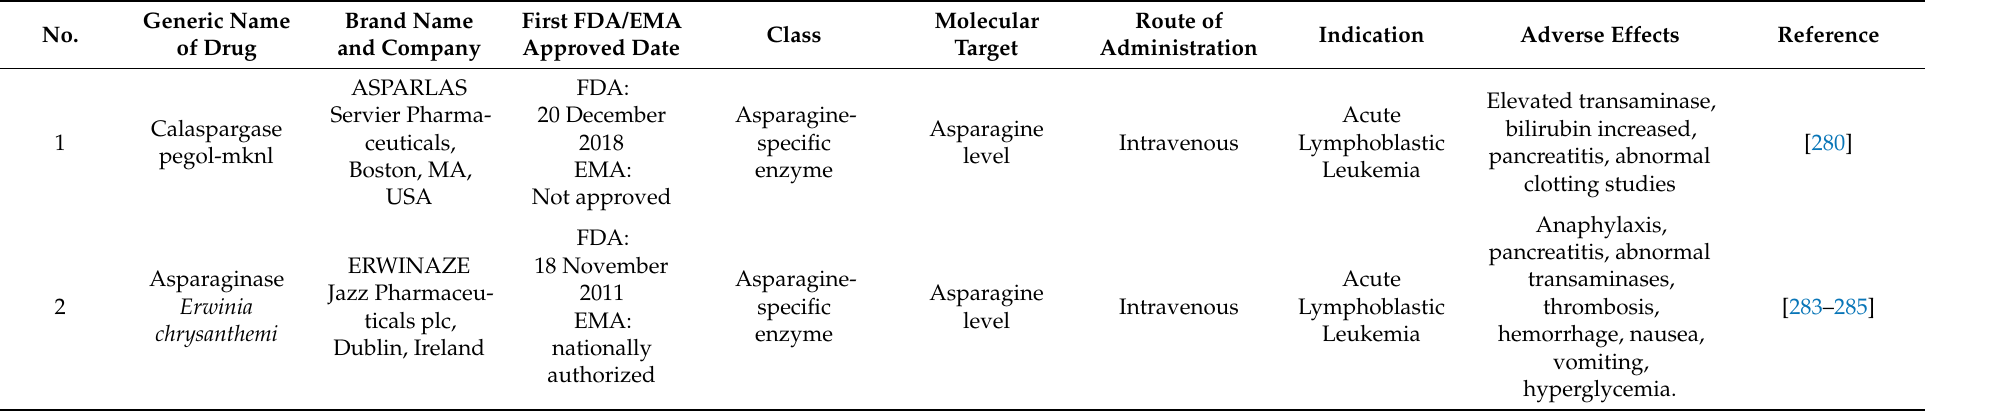
Table 15. Features of the enzymes drugs approved by the Food and Drug Administration (FDA) from 2011 to 2021. The order of drugs is tabulated in order of most recent to oldest registration